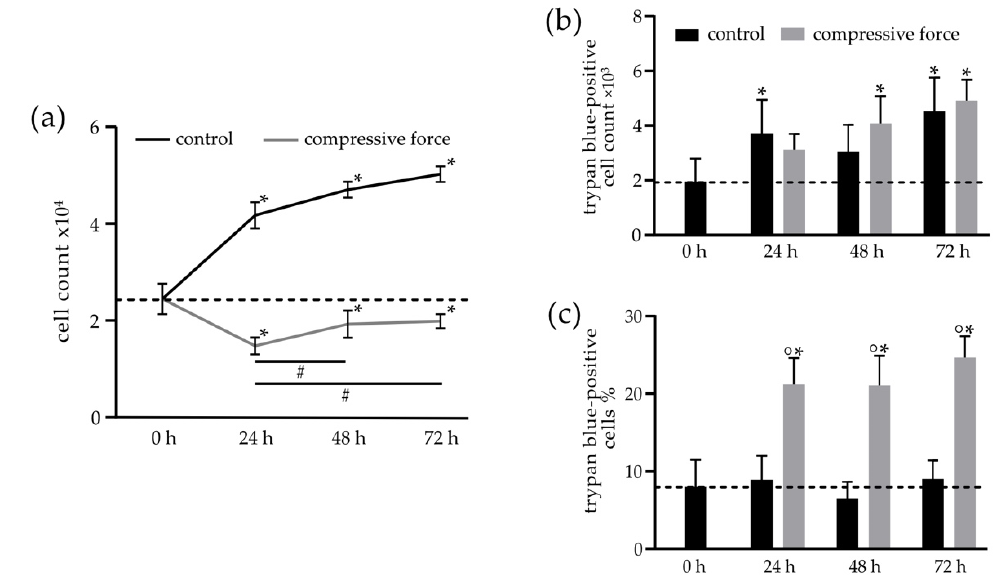
Figure 2. Influence of the compressive force (CF) on the cell count and cell death rate, examined by trypan blue staining. ( a ) Quantification of the total cell numbers ×10 4 in the control (C) and CF groups at 0–72 h. After 24 h, there was a significant reduction in cell numbers compared to the 0-h control in the CF group. Subsequently, the population recovered and approached the baseline value of 0 h again. ( b ) The total number of trypan blue-positive cells increased significantly in both the C and CF groups compared to the 0-h time point. ( c ) A higher percentage of trypan blue-positive cells over the entire study period and unchanged percentage of dead cells in the C group. Bars indicate the mean values ± standard deviations. A p -value of p < 0.05 was considered statistically significant. (*) Comparison of the 24-h, 48-h and 72-h (C and CF) time points with the 0-h control. (°) Comparison of the CF with the respective controls of the time points. (#) Comparisons between different compressive force time points.